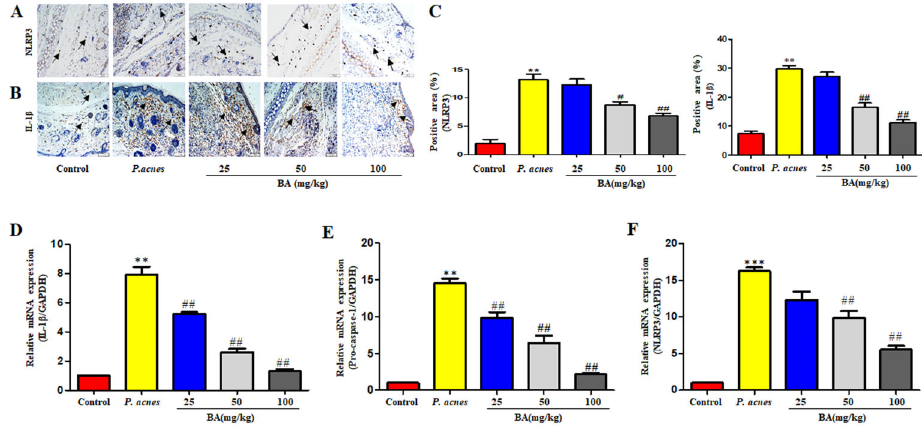
Figure 6. Effect of baicalin (BA) on P. acnes -induced activation of the NLRP3 in fl ammasome in the ears. A and B , Representative images of the immunohistochemical staining of the ear tissue sections for studying the expression of NLRP3 and interleukin (IL)-1 b (scale bar=100 m m). C , Quanti fi cation of the results shown in panels A and B. D – F , Quanti fi cation of IL-1 b , pro-caspase-1, and NLRP3 mRNA transcription levels by qRT-PCR. The data are reported as means ± SE from at least three independent experiments. **P o 0.01, ***P o 0.001 vs control; # P o 0.05, ## P o 0.01 vs P. acnes alone